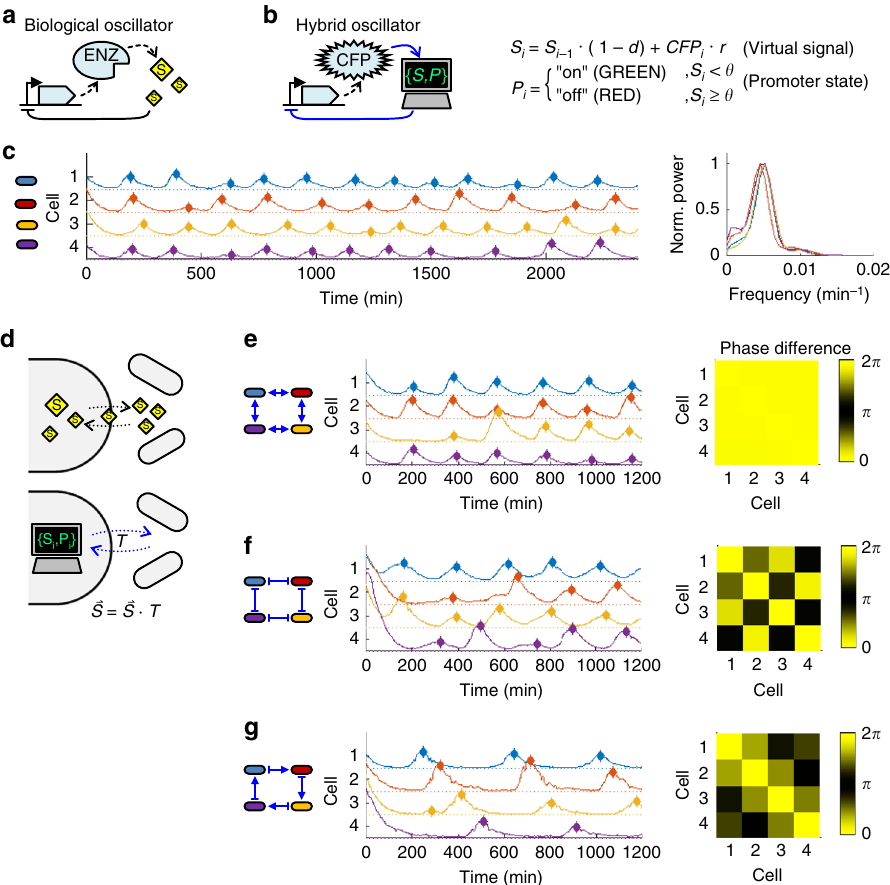
Fig. 5 Digitally speci fi ed communication between single-cell hybrid oscillators. a Simpli fi ed scheme for a biological oscillator driven by a delayed negative feedback 39 on expression of an enzyme (ENZ) by an enzyme-produced inhibitory signal (S). b Analogous architecture of a hybrid oscillator with virtualized inhibitory signal ( S ). A CFP expression reporter and light-responsive promoter interface the biological side of the circuit to a digital component that implements a discrete time CFP-dependent accumulation of virtual inhibitory signal (production rate r , removal rate d ) and exposes cells to red or green light stimuli determined by virtual signal-dependent threshold ( θ ) activation of the digital promoter state ( P ). c Raw CFP fl uorescence trajectories of four single-cell hybrid oscillators over 40 h (left panel; r = 3, d = 0.2, θ = 60). Filled diamonds denote expression peaks of the trajectories ( fi t after local smoothing), for comparing oscillation timing between cells. Median trough, peak fl uorescence: 2.0 a.u., 10.9 a.u., respectively. Power spectra (right panel) of the (mean-subtracted) trajectories exhibit a common peak frequency around 0.005 min − 1 . d Biological oscillators can be coupled by transporting a chemical signal, S, across cell boundaries (top). The hybrid oscillators can similarly distribute a virtual signal between cells by multiplying their signal * vector, S , with a digitally speci fi ed transfer matrix, T , at each time step. e CFP trajectories of four coupled hybrid oscillators (left schematic and middle panel; r = 3, d = 0.2, θ = 60, for every cell, 0.1 S is transferred to the nearest neighbors, per interval). Coincidence of expression peaks ( fi lled diamonds) and near zero phase difference (right panel) indicate synchrony of the oscillators. Median trough, peak fl uorescence: 1.8, 13.6 a.u. ( f , g ). CFP trajectories (middle panel; fi lled diamonds: expression peaks) and phase difference (right panel) of 4-member f negatively coupled ( r = 3, d = 0.2, θ = 60, for every cell, 0.1 S is removed from the nearest neighbors per interval; median trough, peak fl uorescence: 3.2, 18.9 a.u.), and g asymmetrically coupled ( r = 3, d = 0.16, θ = 60, for every cell, 0.1 S is respectively added and removed from the left- and right-hand nearest neighbors, per interval; median trough, peak fl uorescence: 1.5, 16.3 a.u.) groups of hybrid